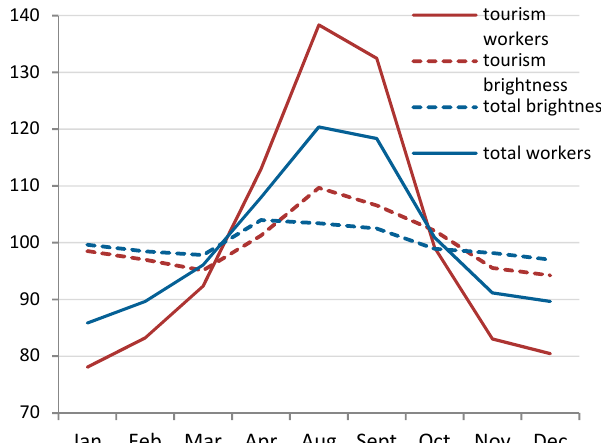
Figure 9. Annual evolution of workers affiliated to the Social Security and total emitted light with respect to its annual mean on the 100 index for the Balearic Islands and their tourist districts. Source: Based on VIIRS images and affiliated workers, according to the Ministry of Labor and Social Security.